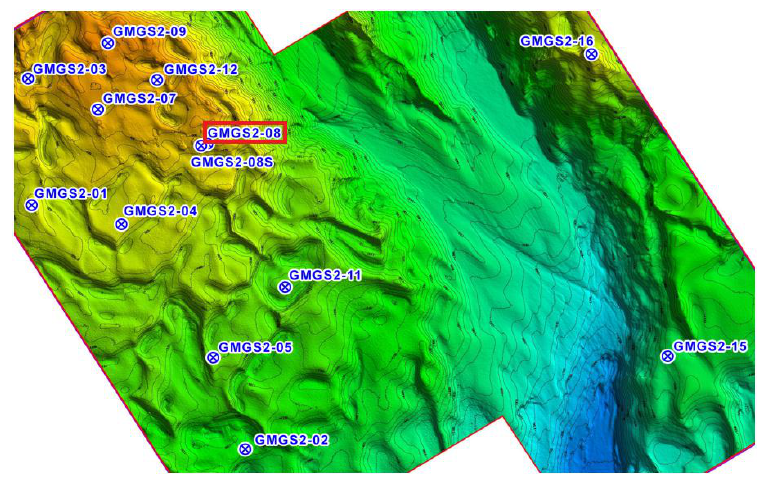
Figure 2. Bathymetric map of gas hydrate drilling area and sites.